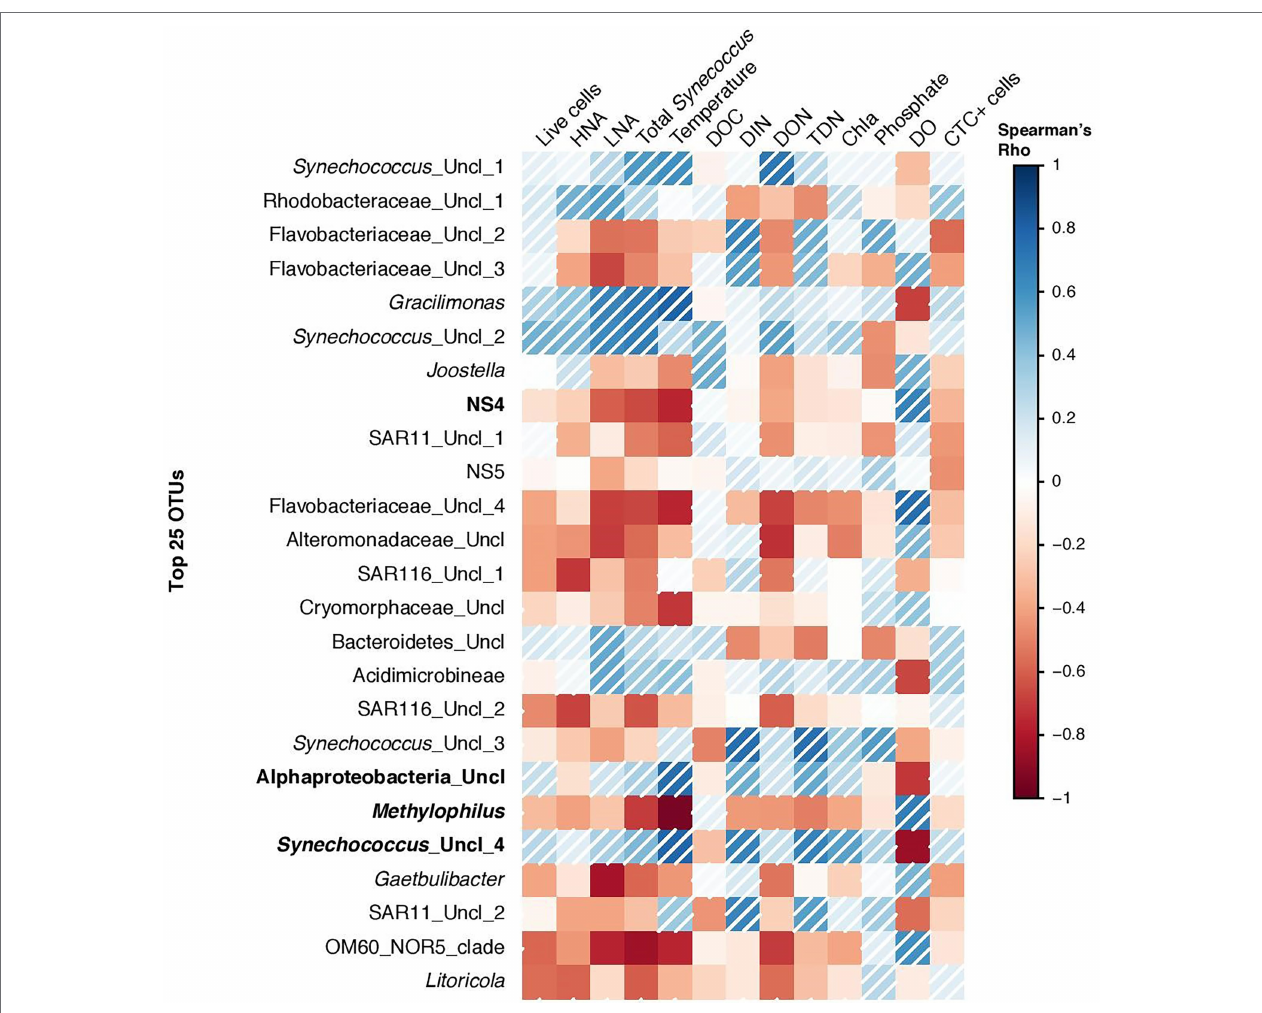
FIGURE 7 | Spearman correlation coefficients between the top most abundant 25 OTUs and bacterial and environmental factors at the coastal site (in the Red Sea). Bold OTUs represents new genera or group of bacteria showing highest Spearman correlations with temperature or